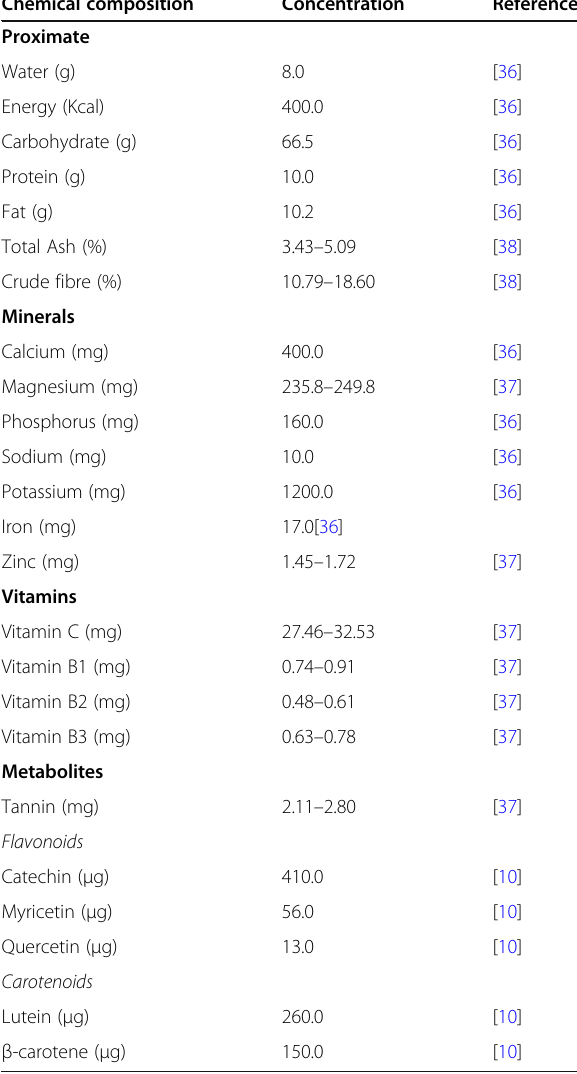
Table 1 Nutritional composition of 100 g of black pepper Chemical composition Concentration